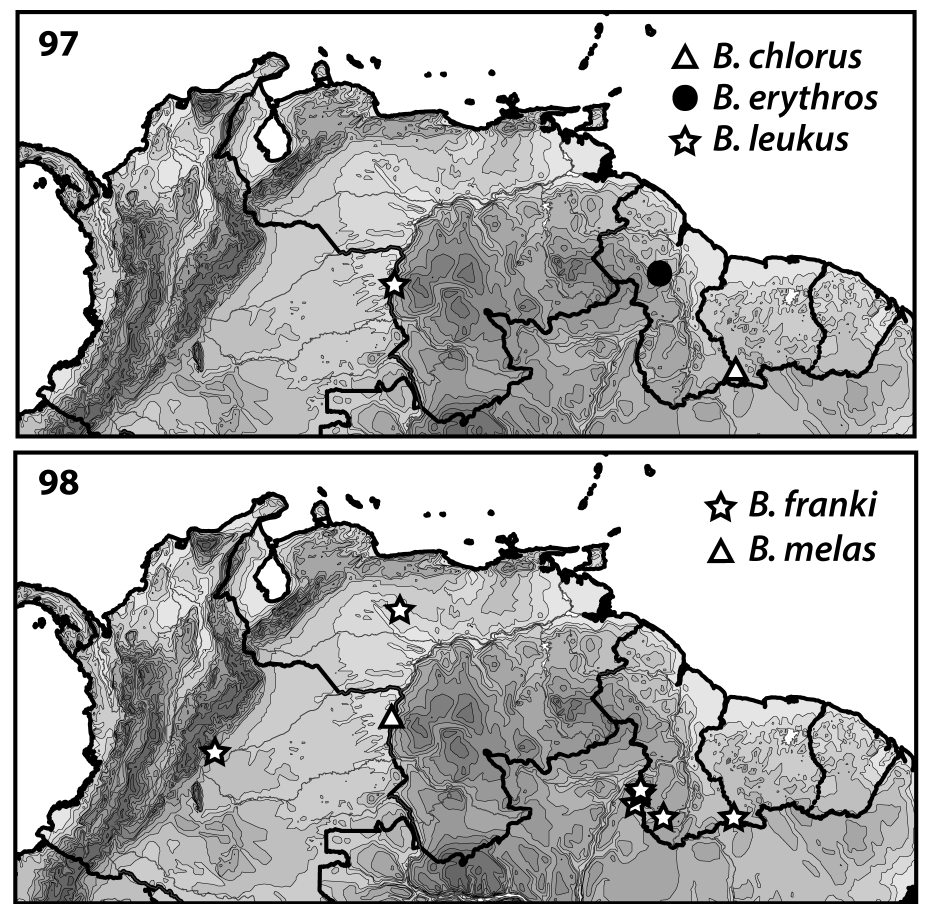
Figures 97–98. Distributions of Bidessodes species based on examined specimens and published